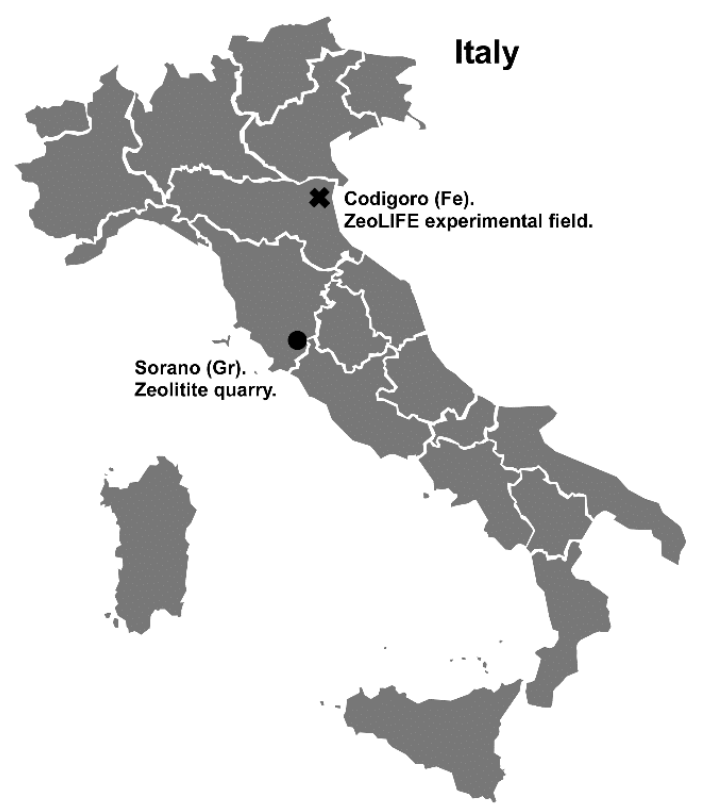
Figure 1. Location of the exploited zeolitite quarry and ZeoLIFE experimental field.